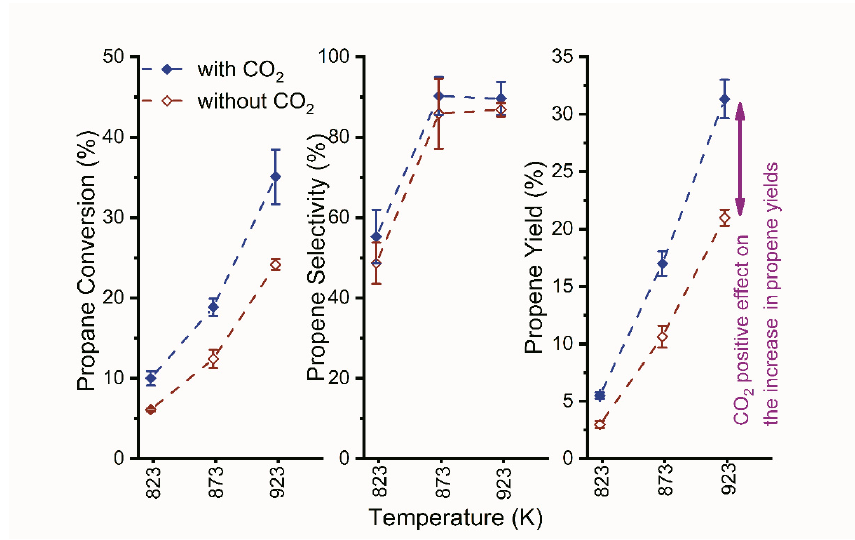
Figure 9. Mean values (for TOS = 20–120 min) of propane conversion, propene selectivity, and yield of the propane dehydrogenation in the presence/absence of CO 2 on the ZnSiBEA catalyst. These results clearly indicate a positive effect of CO 2 on the production of the target product, propene. At the same time, the presence of CO 2 in the reaction medium does not counteract the coking of the catalyst, as evidenced by the slopes of the curves of changes in propane conversion and propene yield over time (dependence of X C3H8 and Y C3H6 on TOS).